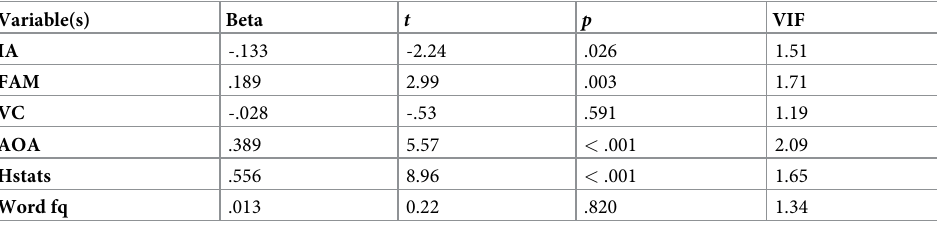
Table 5. Standardized coefficients and R 2 changes in multiple regression